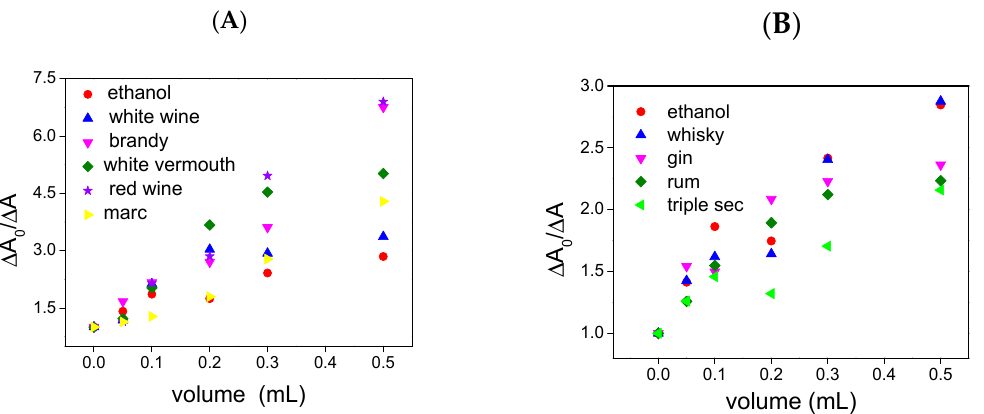
Figure 3. Stern–Volmer-like plots obtained as the ratio ∆ A o / ∆ A x versus added volume of the different beverages (values taken from Figure 2). ( A ) drinks derived from grapes; ( B ) distillates non-derived from grapes.